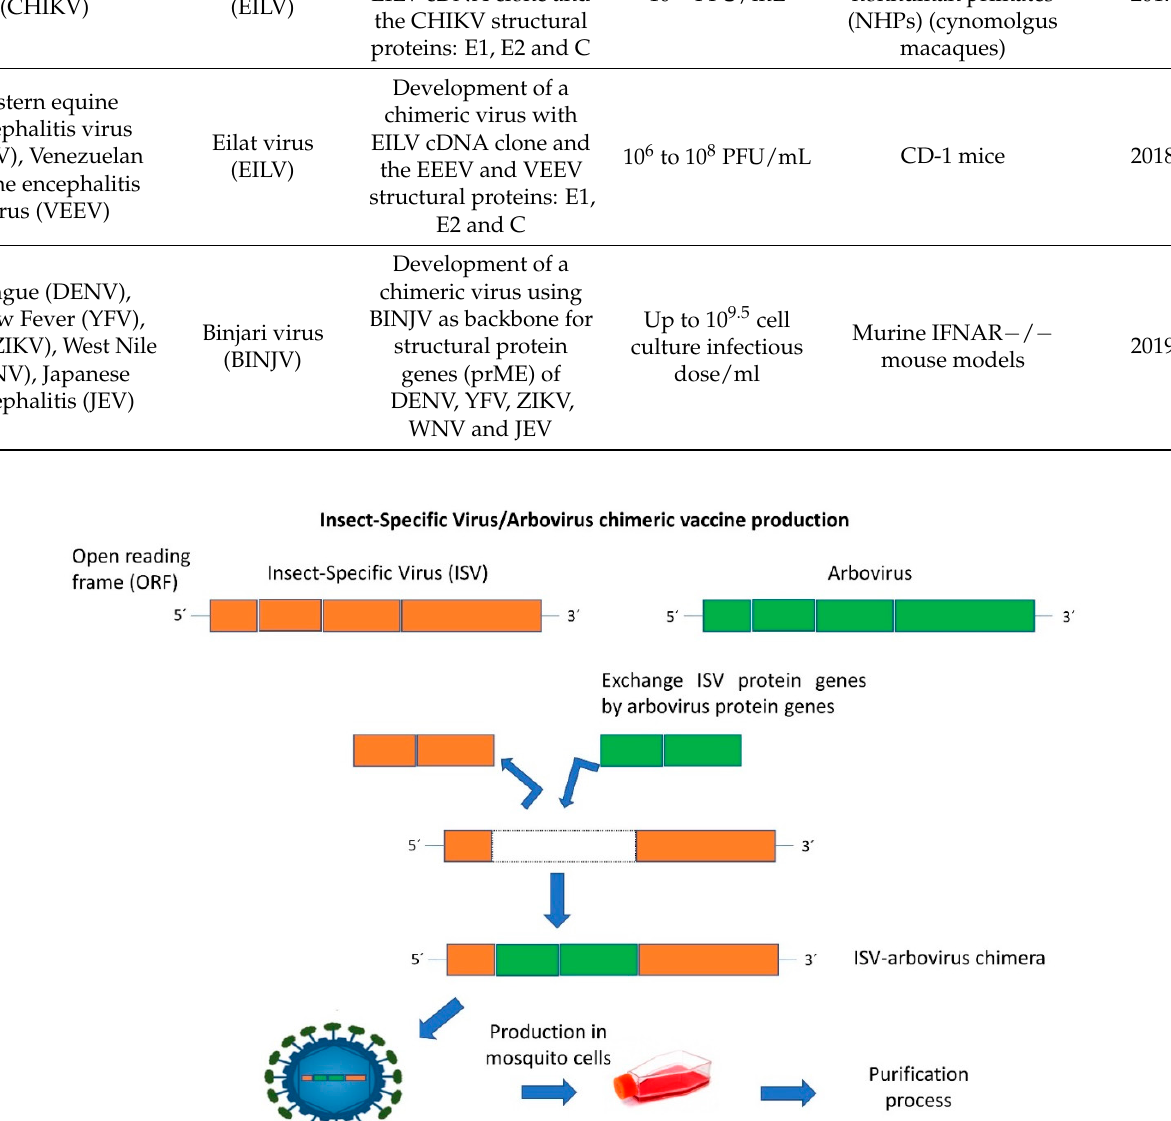
Table 1. Insect ‐ specific virus ‐ based vaccines developed against arboviruses.